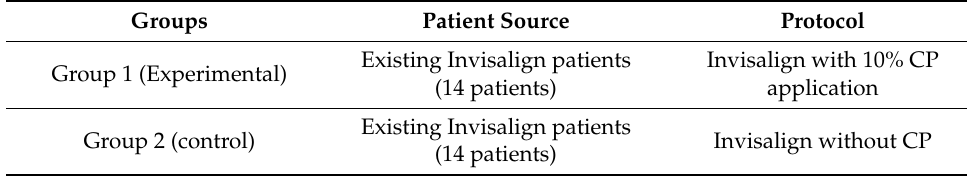
Table 1. Study participants were divided into 2